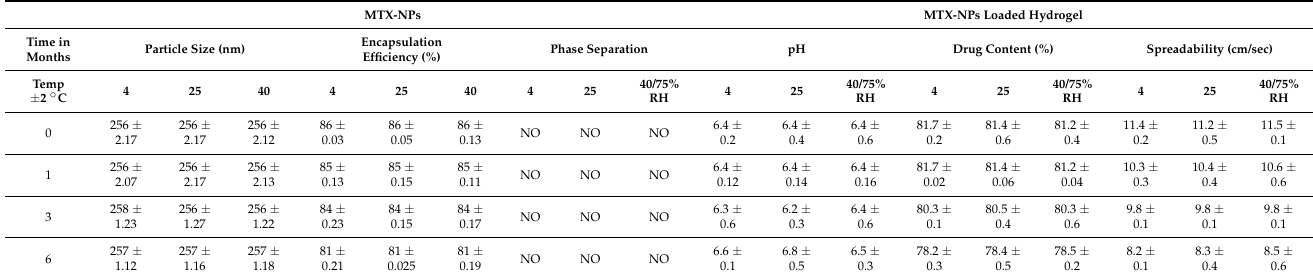
Table 2. Stability studies of NPs and hydrogel